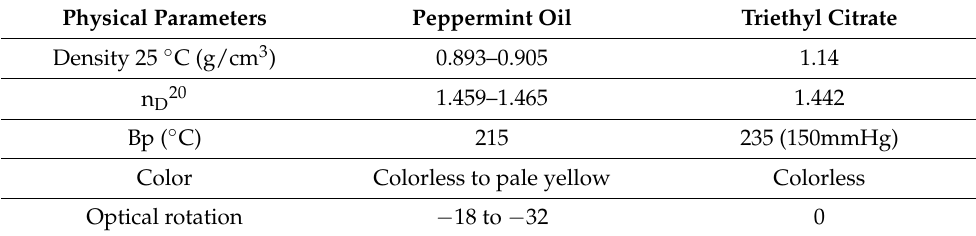
Table 3. Physical parameters of peppermint oil and triethyl